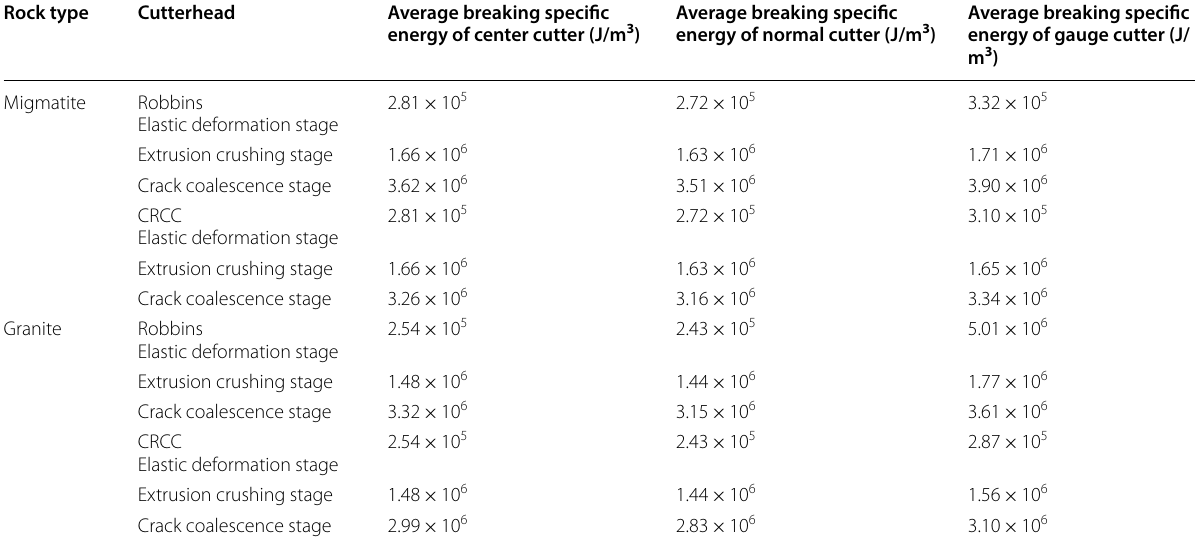
Table 4 Energy consumption of rock cutting Rock type